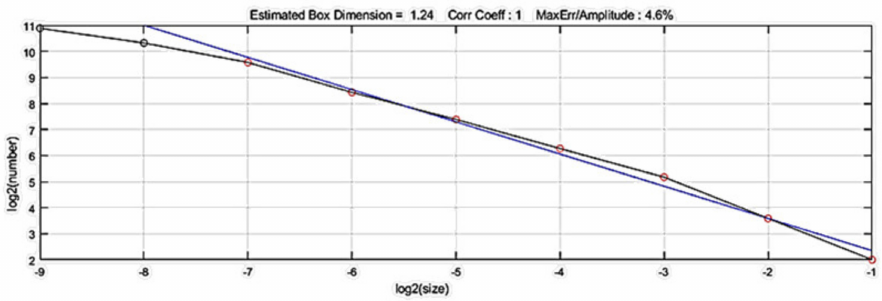
Figure 3. Calculation results of the box-counting dimension of the Koch